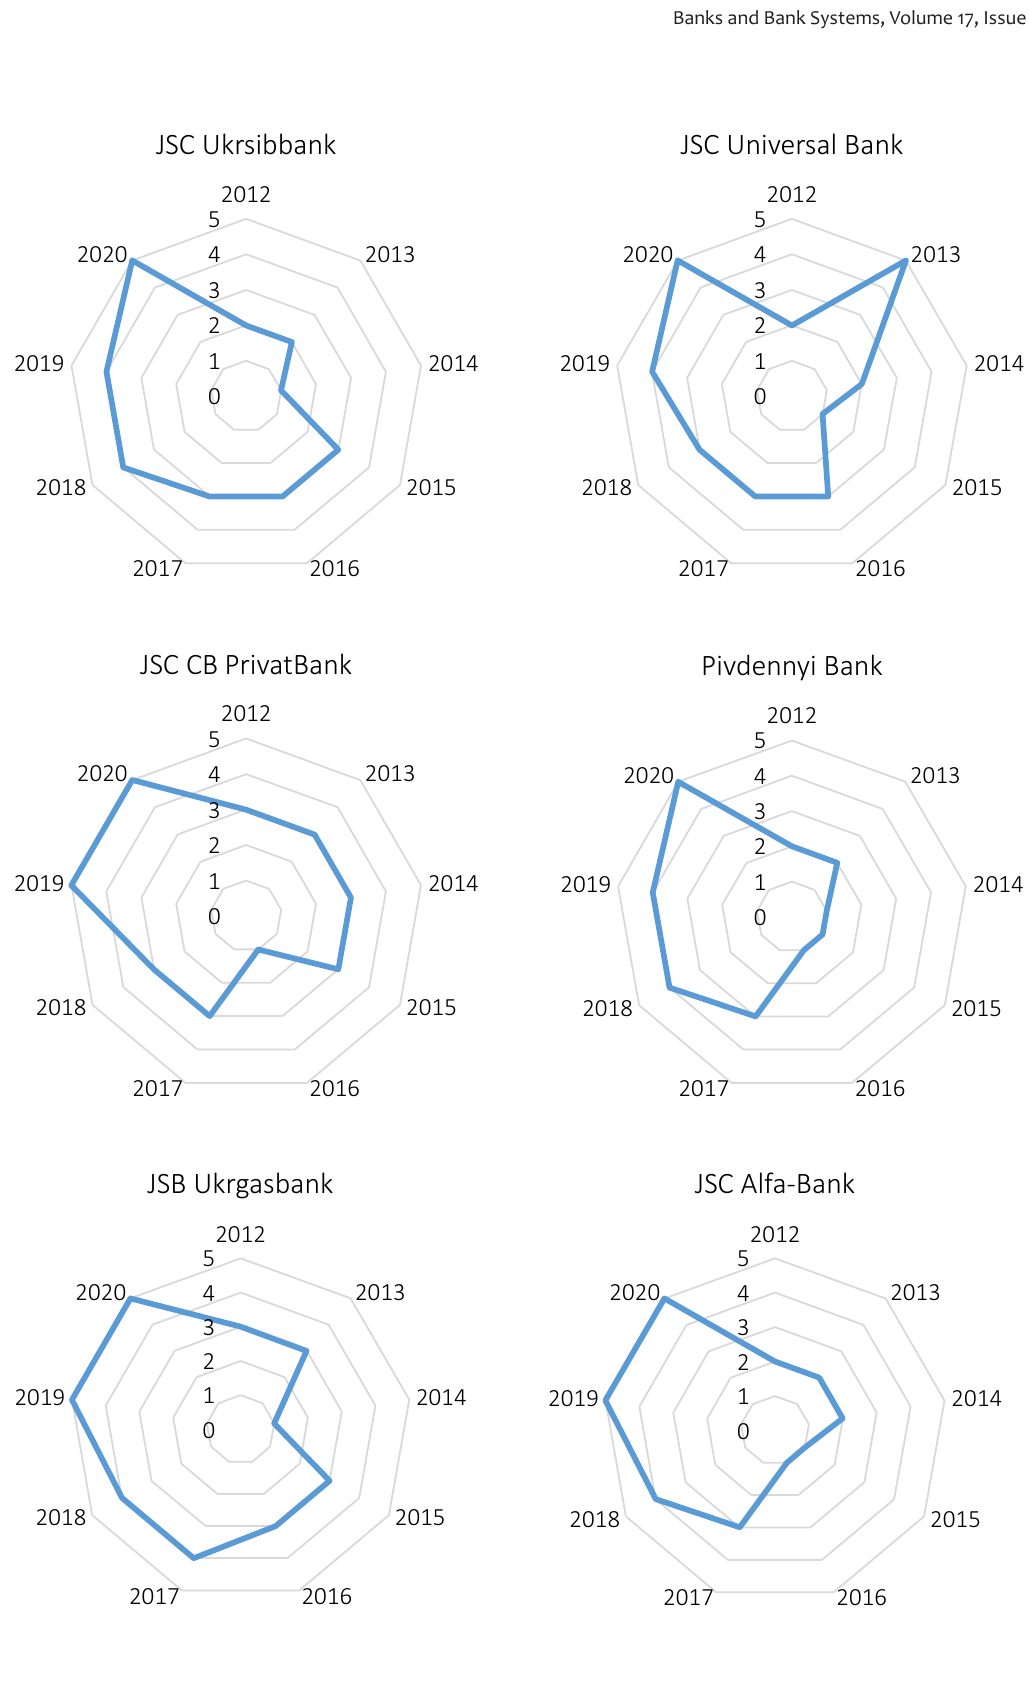
Figure A1 (cont.). Development patterns of financial intermediaries’